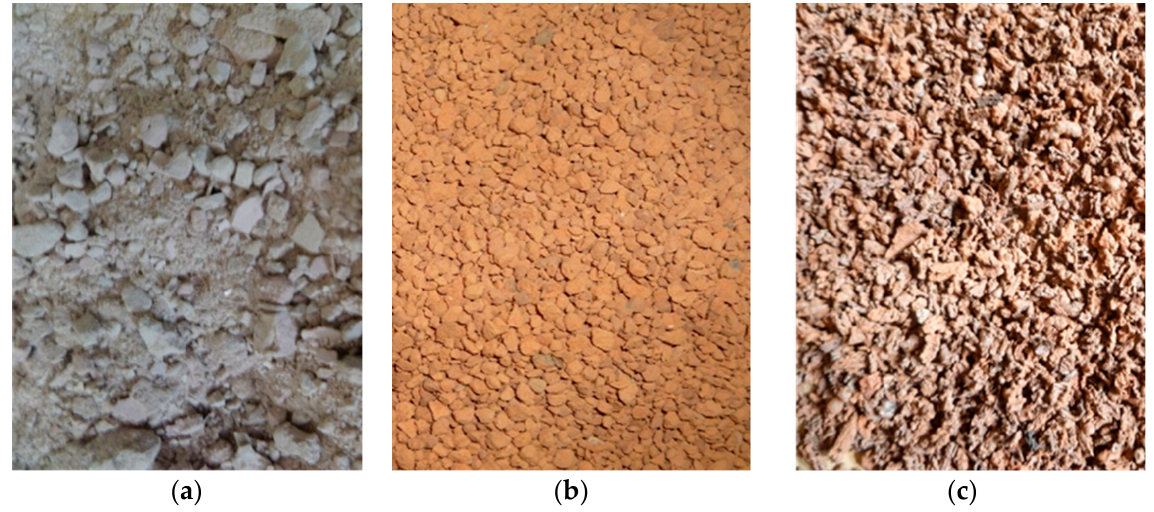
Figure 2. The recycled aggregates used in tests: ( a ) crushed concrete; ( b ) crushed ceramic brick; ( c ) burnt sewage sludges. ( c ) burnt sewage